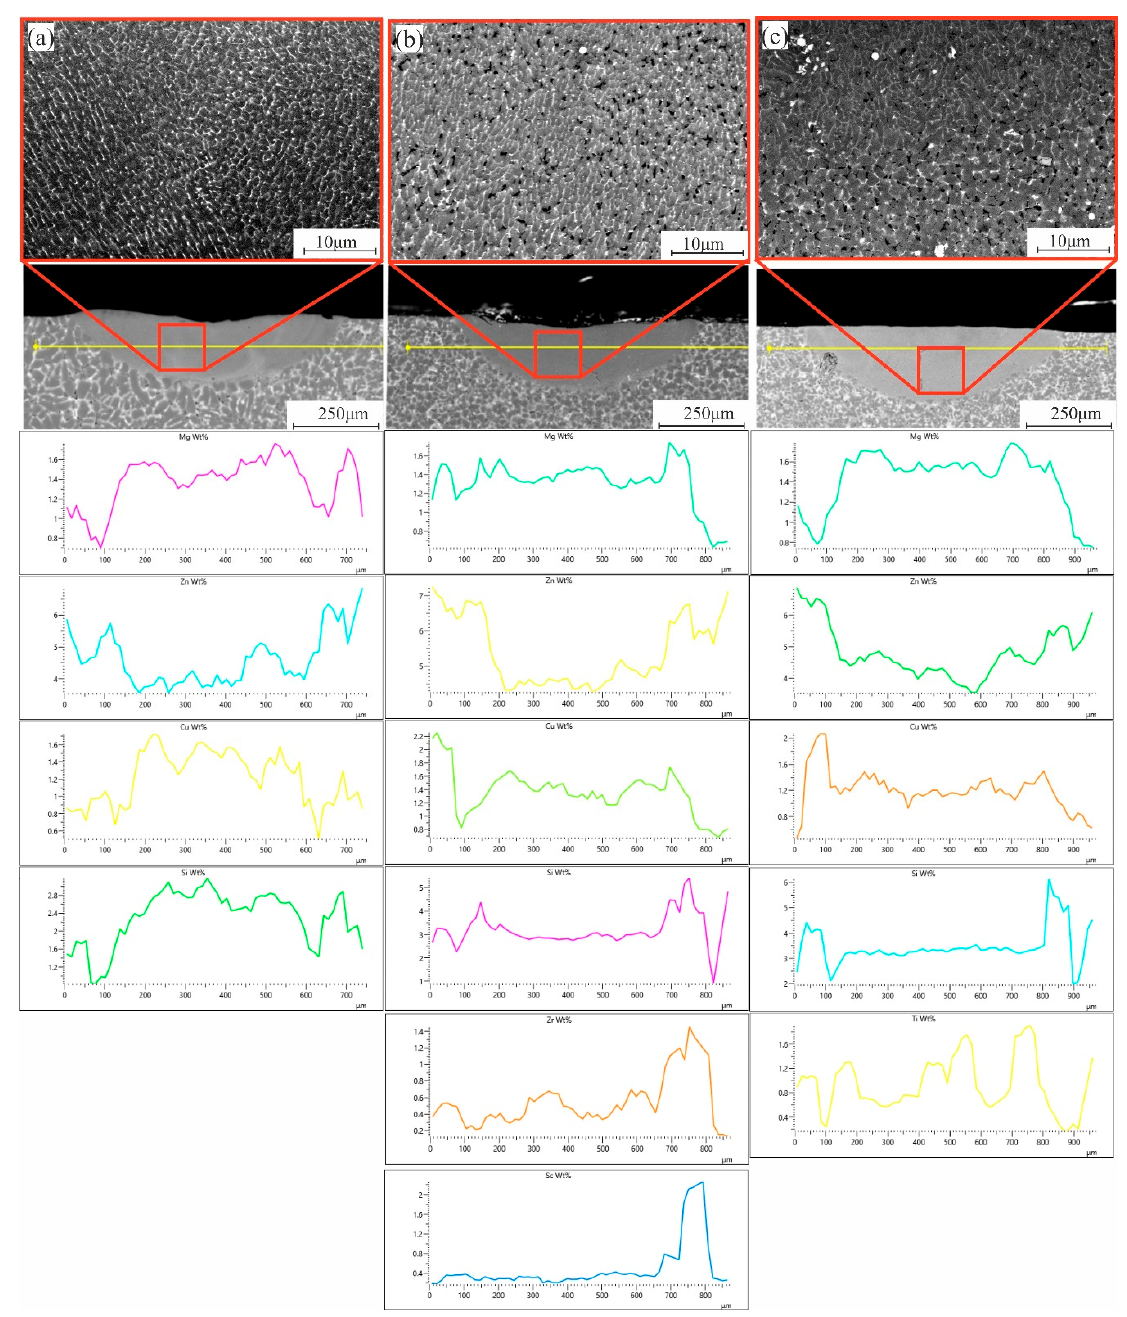
Figure 7. SEM micrographs and elemental distribution of the LMZ of the as-casted samples; ( a ) 7075-4%Si, ( b ) 7075-4%Si + ScZr, and ( c ) 7075-4%Si + TiB.